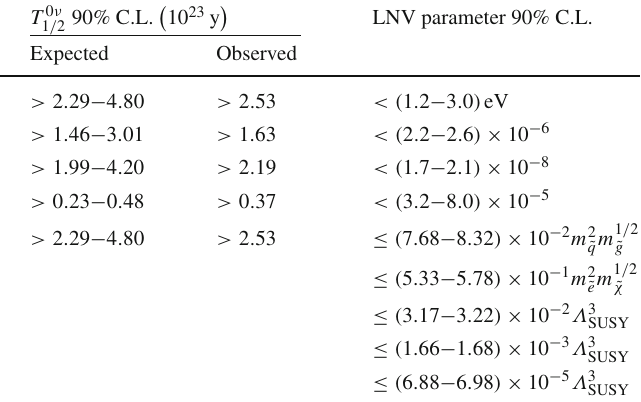
Table 5 Limits from 0 νββ searches for different decay modes in 82 Se. The signal efficiency and the 90% C.L. limits for half-lives and lep- ton number violating (LNV) parameters are shown. The ranges in the expected half-life limits are the ± 1 σ range of systematic uncertainties 0 νββ